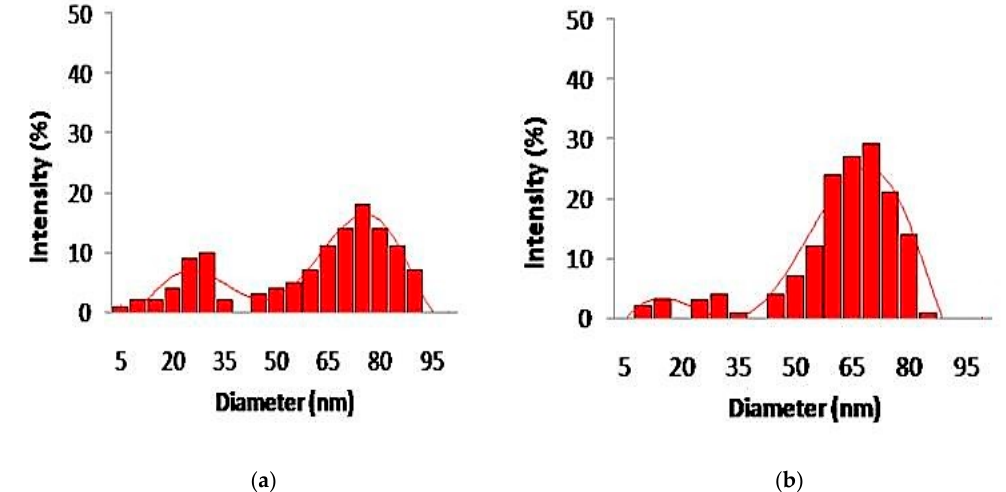
Figure 8. The size distribution of nanoparticles synthesized by Thraustochytrium kinnei through Dynamic Light Scattering (DLS): ( a ) silver; ( b ) gold.